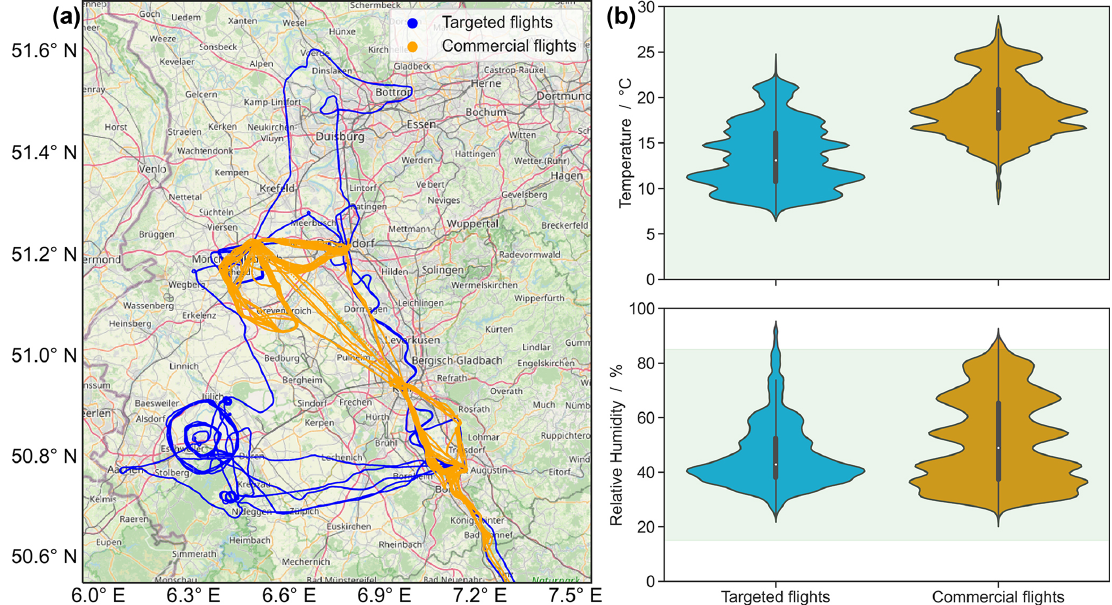
Figure 2. (a) Map with flight paths in North Rhine-Westphalia, Germany (©OpenStreetMap contributors 2021. Distributed under the Open Data Commons Open Database License (ODbL) v1.0), and (b) the frequency distribution of the corresponding temperature and relative humidity in-flight values for the targeted (blue) and commercial (orange) flights, as illustrated in violin plots. The manufacturer-specified limits within which the sensors should be used are depicted in shaded green in the